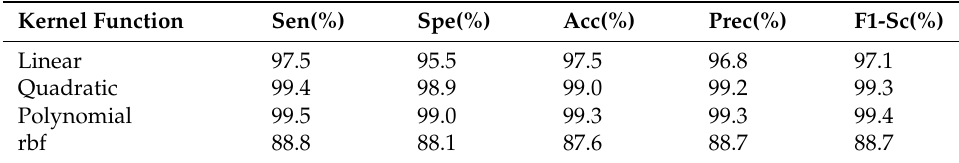
Table 5. Different kernel function of SVM for hybrid features.